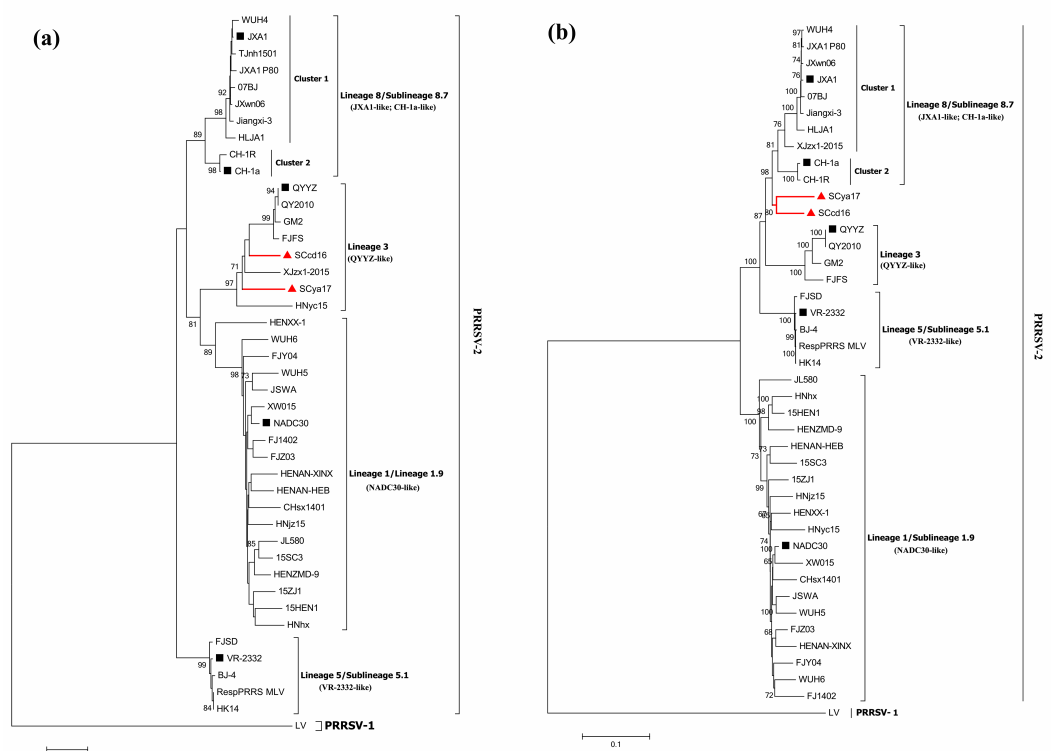
Figure 2. Phylogenetic trees based on ORF5 ( a ) and full-length genomic sequence ( b ) of SCcd16 and SCya17 isolates with 40 PRRSV reference strains available in GenBank. The two isolates in this study are labeled with “red triangle”. The representative strains are labeled with “black squares”. along branches are bootstrap values. Scale bar indicates nucleotide substitute per